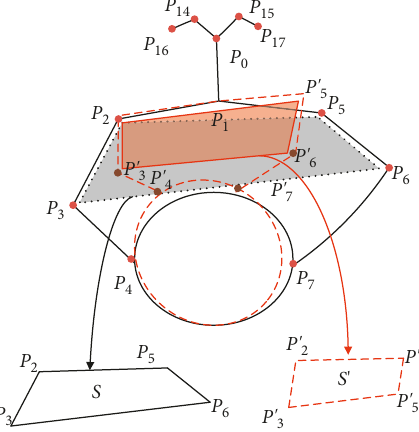
Figure 5: Schematic diagram of elbow changes.